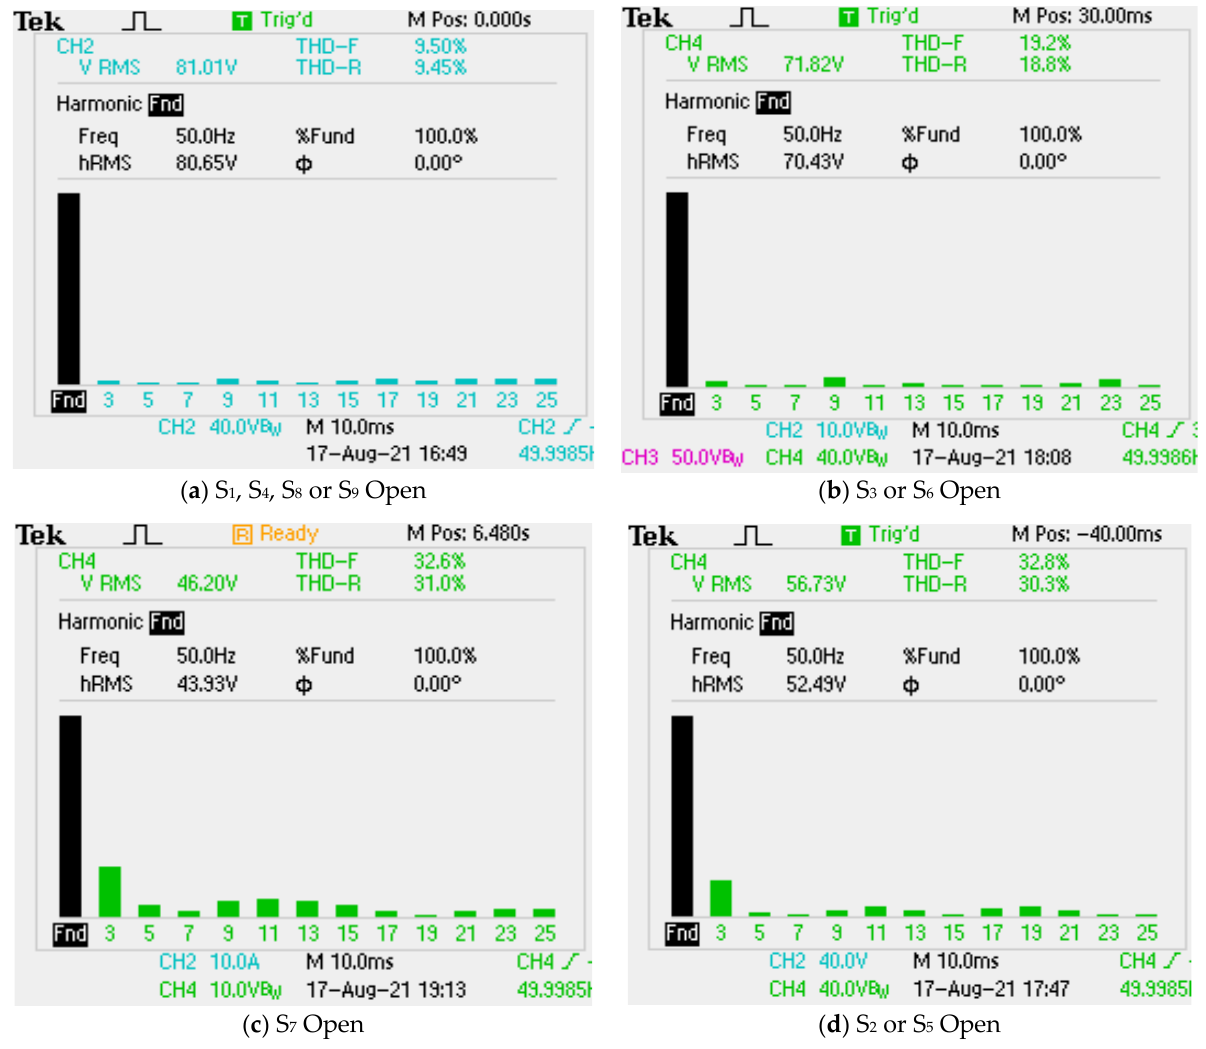
Figure 11. Experimental verification of Voltage THD profiles for clearing of faults in: ( a ) S 1 , S 4 , S 8 or S 9 , ( b ) S 3 or S 6 , ( c ) S 7 and ( d ) S 2 or S 5 .